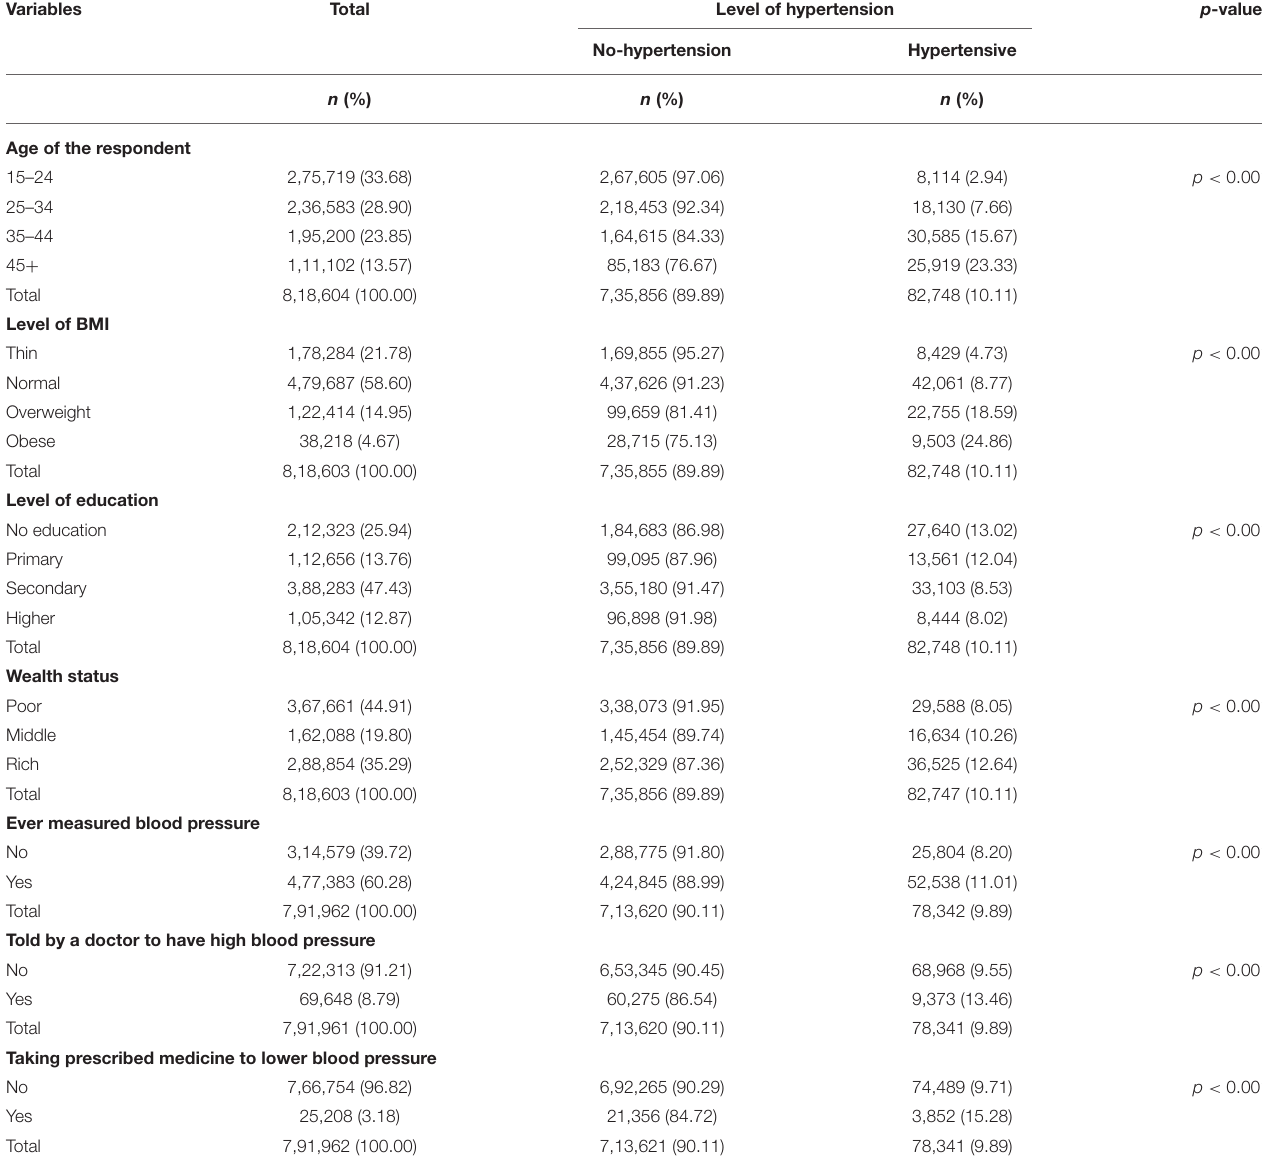
TABLE 1 | Background characteristics of the participants ( N =